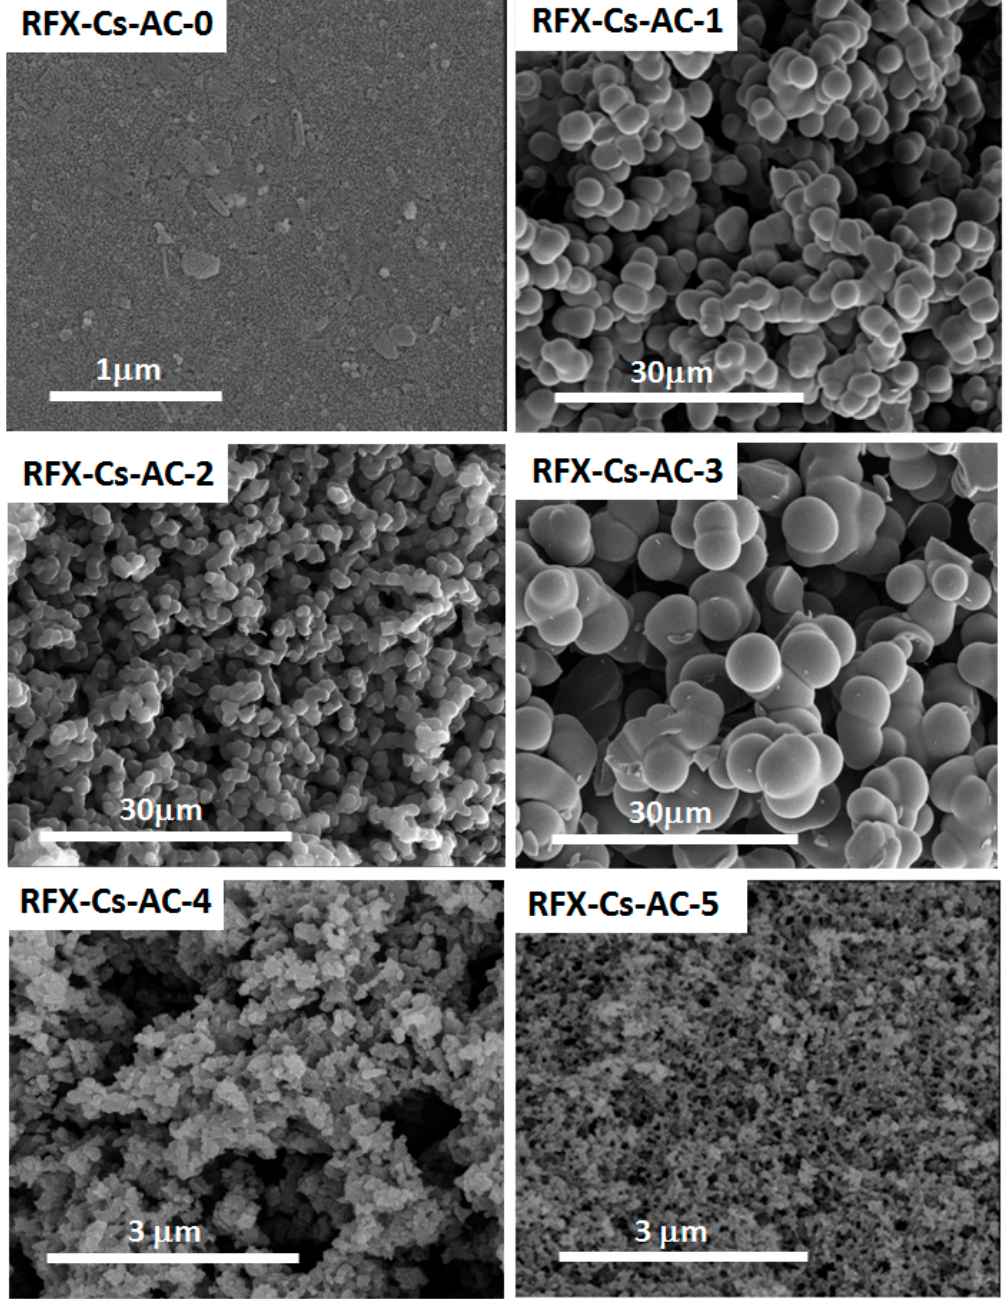
Figure 2. NanoSEM photomicrographs of RFX-Cs-AC samples. Table 2. TGA weight losses (%) of RFX-Cs-AC samples.